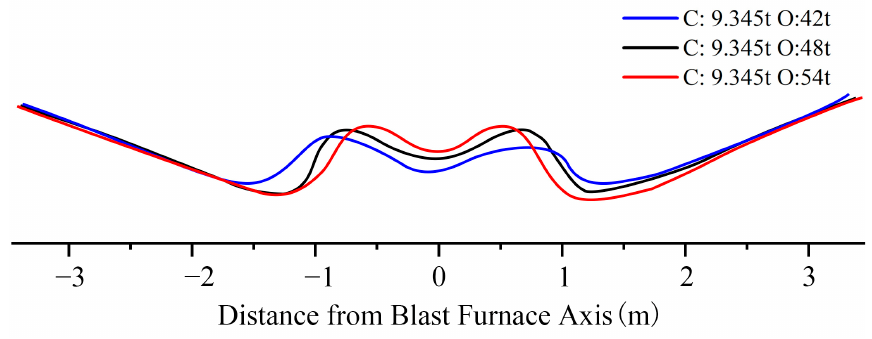
Figure 10. E ff ect of di ff erent burden line depths on the ore-to-coke ratio within the ore-free zone. Figure 10. Effect of different burden line depths on the ore-to-coke ratio within the ore-free zone.